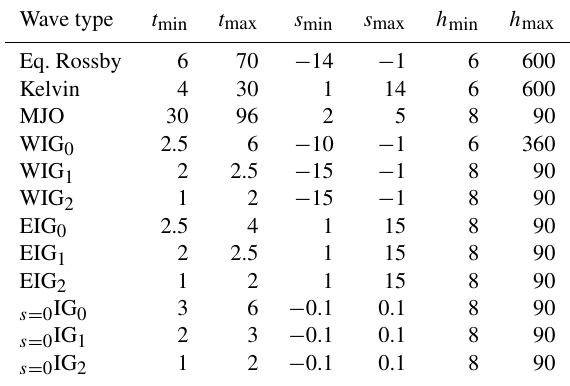
Table 1. Parameters used to bound the filter of the different equato- rial wave types, with the meridional mode n as subscript: t (period, in days), s (zonal planetary wavenumber) and h (equivalent depth, in